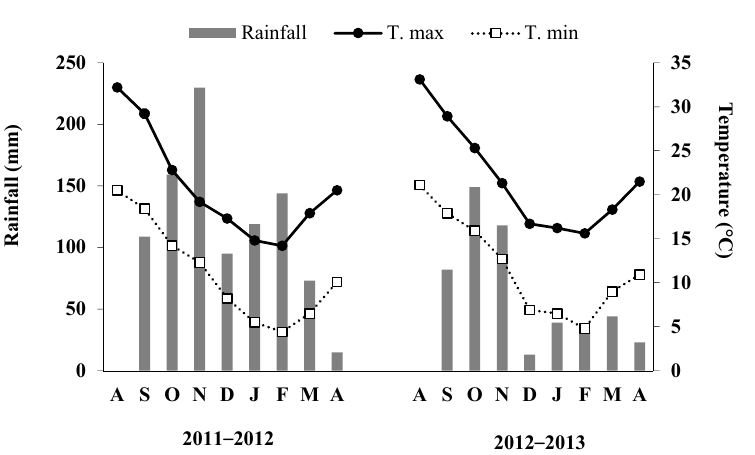
Figure 2. Total rainfall, mean monthly maxima and minima temperatures at the experimental site during 2011–2013.